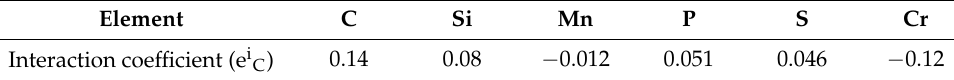
Table 5. Interaction coefficient between other elements and carbon in hot metal at 1600 ◦ C, data from [26].